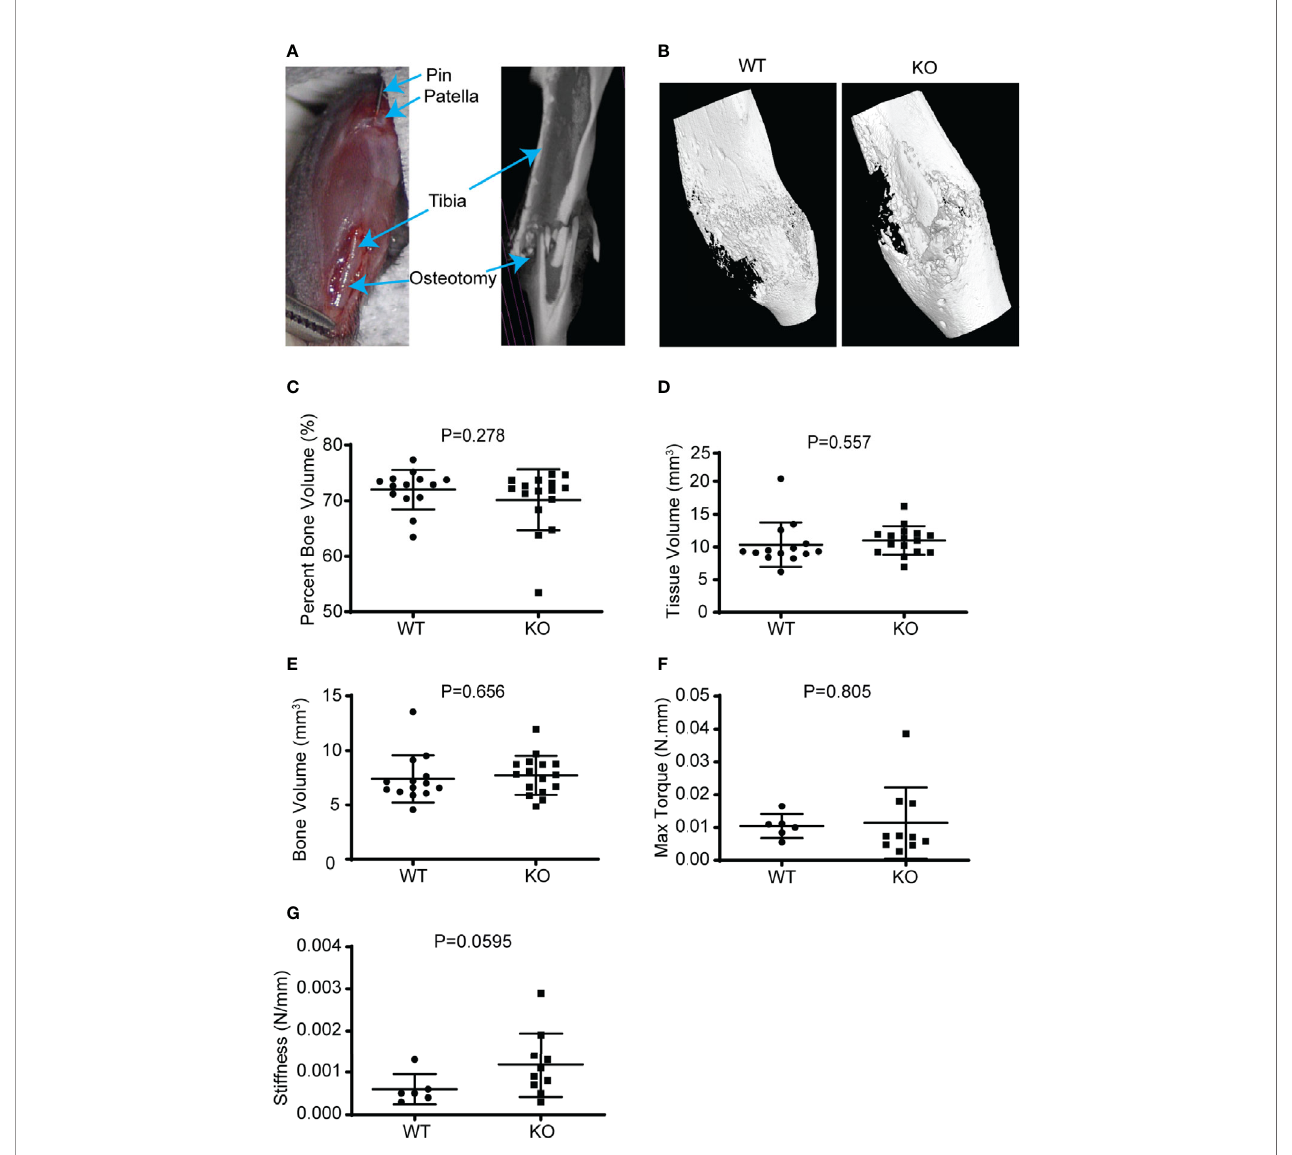
FIGURE 5 | Hematopoietic depletion of Wnt does not affect callus volume and early healing. (A) Illustration of murine fracture model with a diaphyseal osteotomy stabilized with an intramedullary stainless-steel pin. (B) µCT reconstructed 3D images showed that the KO mice healing fracture callus had similar gross dimensions compared to the WT, 3 weeks after injury. (C – E) µCT volumetric analysis of the 3-week-old fracture callus by percentage bone volume (%), tissue volume (mm 3 ), and bone volume (mm 3 ); showed that the KO mice had normal callus bony volume and density. (F, G) Mechanical evaluation of the fracture callus at 3 weeks by maximum torque (Newton.mm), and stiffness (Newton/mm) were similar for both the KO and WT